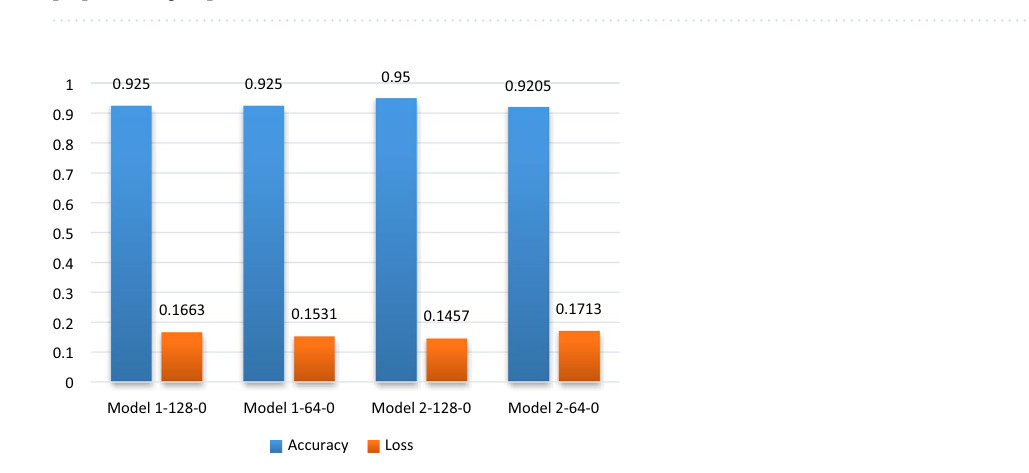
Table 1. Different preprocessing steps and their respective AUC score. Bold shows the best combination for preprocessing step.